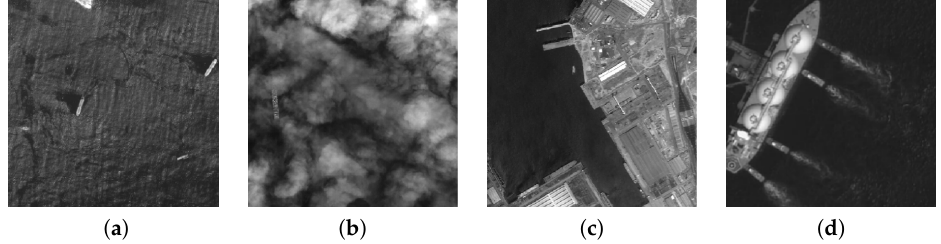
Figure 7. Examples of different scenarios in the ChangGuang dataset. ( a ) Ocean wave scene, ( b ) cloud and fog scene, ( c ) nearshore scene, ( d ) scenes with different target scales.